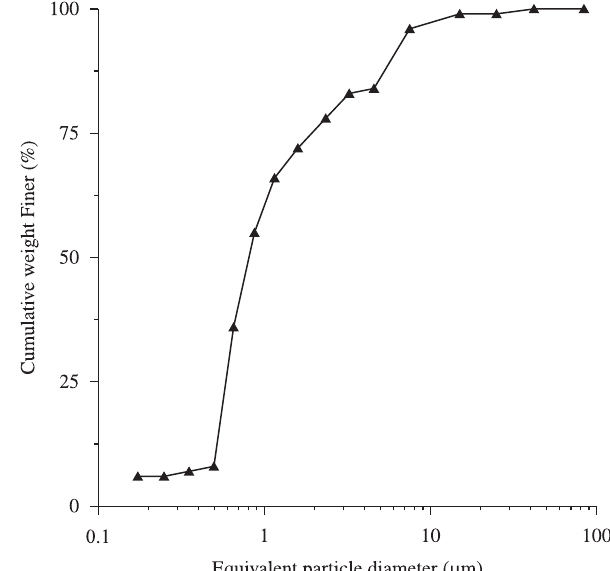
Figure 2. EAFD size distribution.